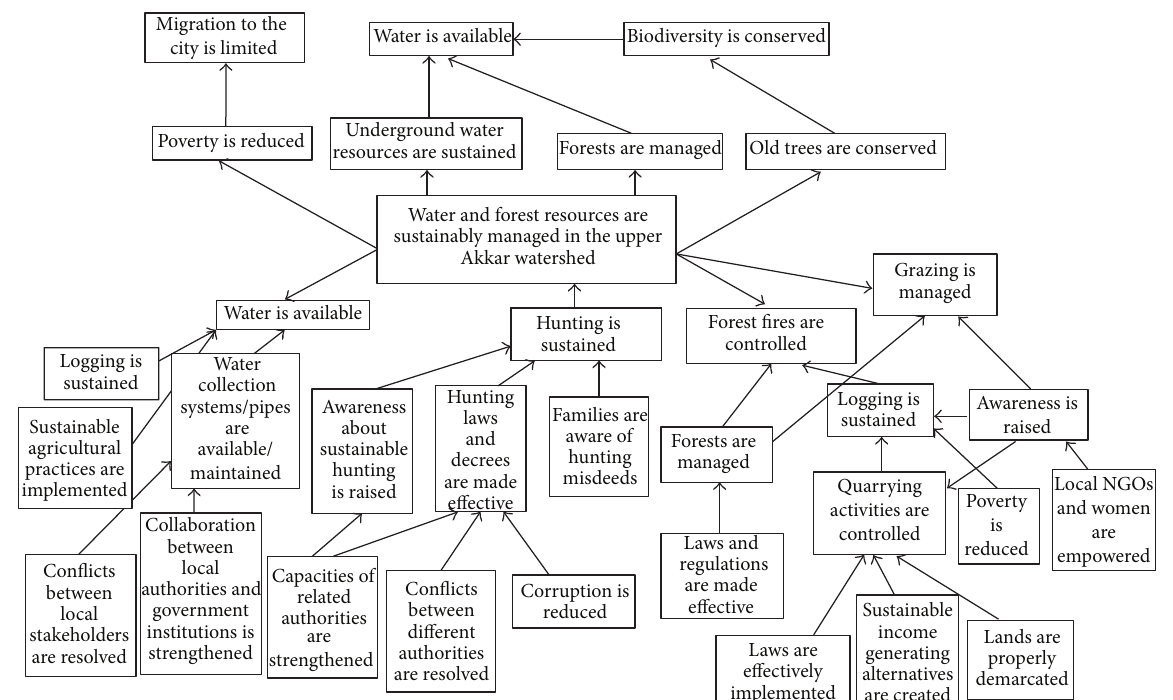
Figure 3: Objective tree for sustainable management of water and forests resources in the upper Akkar